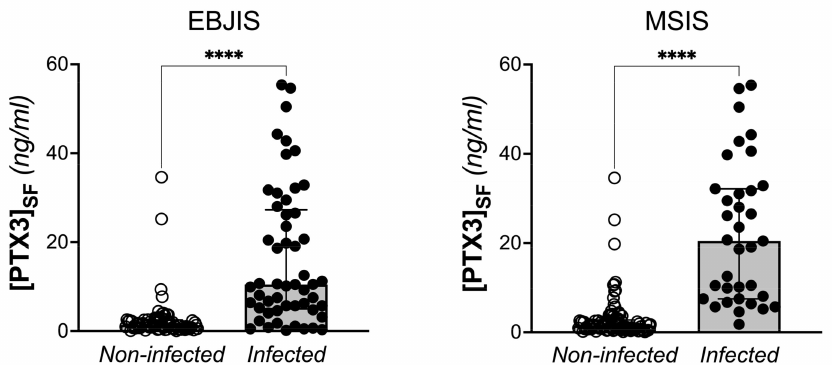
Figure 2. Concentration of PTX3 in the synovial fluid of THA and TKA patients with and without PJI, based on EBJIS and MSIS criteria (Mann-Withney test, **** p < 0.0001).